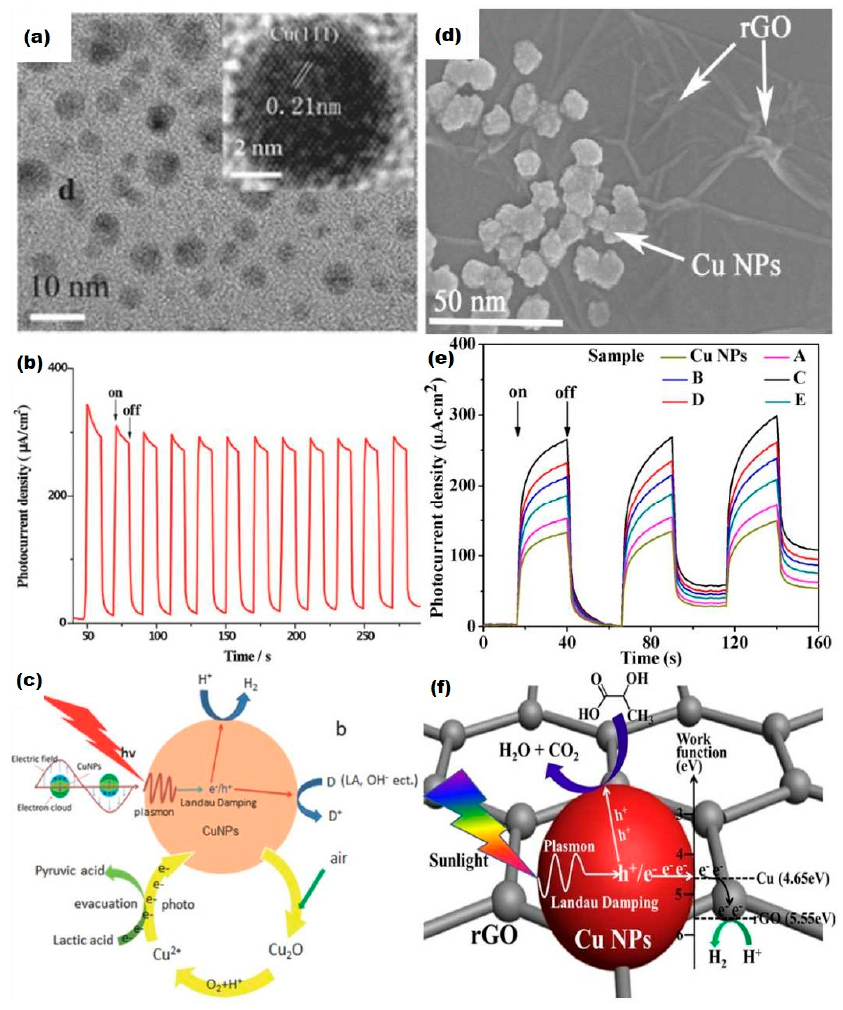
Figure 7. Plasmonic Cu and Cu-based hybrid materials and their photocatalytic application ( a ) HRTEM images of CuNPs synthesized by photoreduction, ( b ) Transient photocurrent responses of the CuNPs under UV–vis light irradiation, ( c ) Schematic of CuNP photocatalysis. Reproduced with permission from [51]. Copyright John Wiley and Sons, 2015. ( d ) SEM image of CuNP/rGO, ( e ) Transient photocurrent responses of CuNP/rGO, ( f ) Schematic of HER of CuNP/rGO. Reproduced with permission from [59]. Copyright Elsevier,